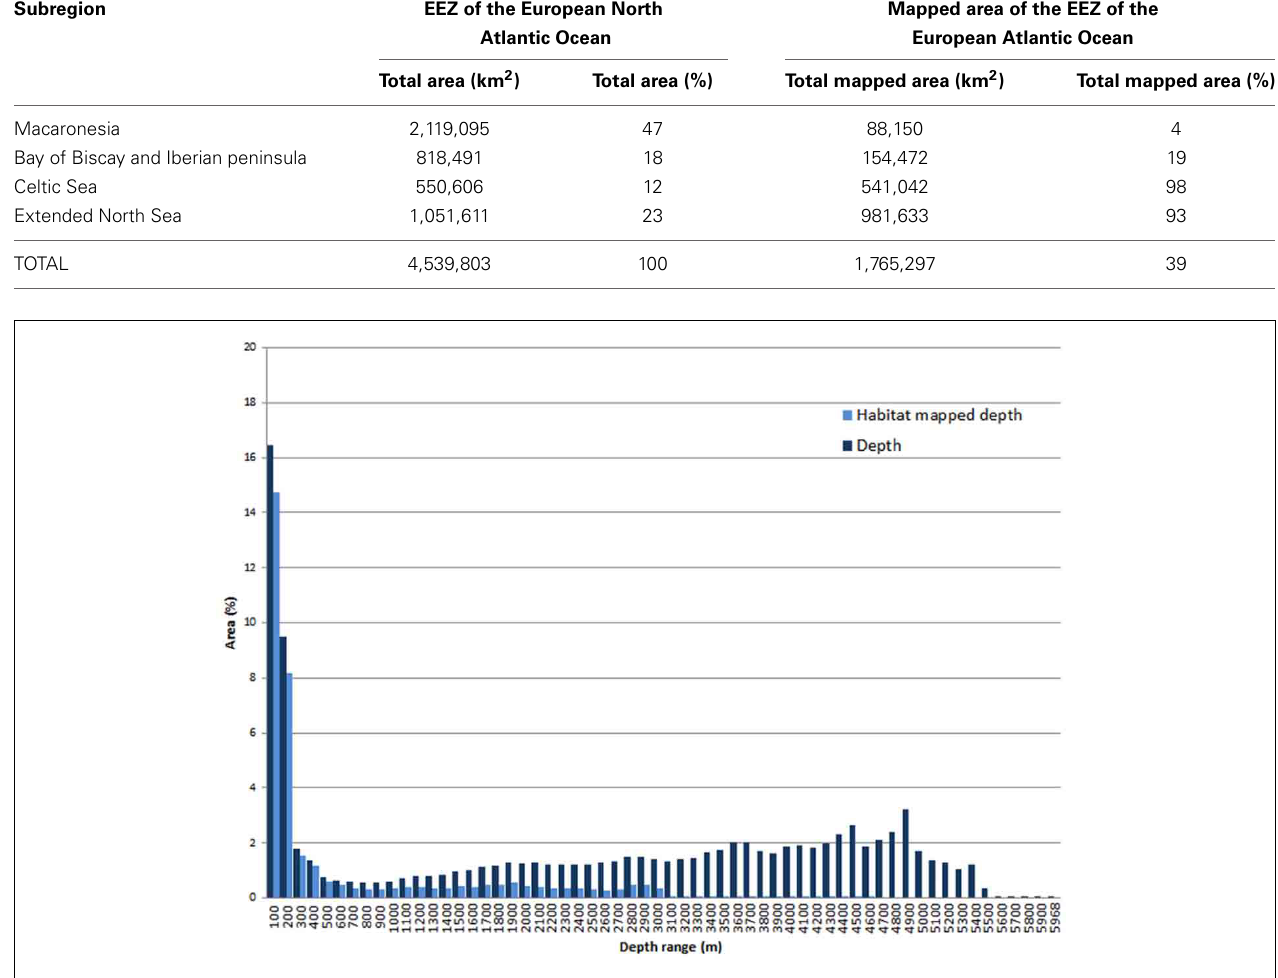
FIGURE 2 | Depth distribution of the Exclusive Economic Zone of the European North Atlantic Ocean (dark blue) and depth distribution of habitat-mapped areas (light blue).